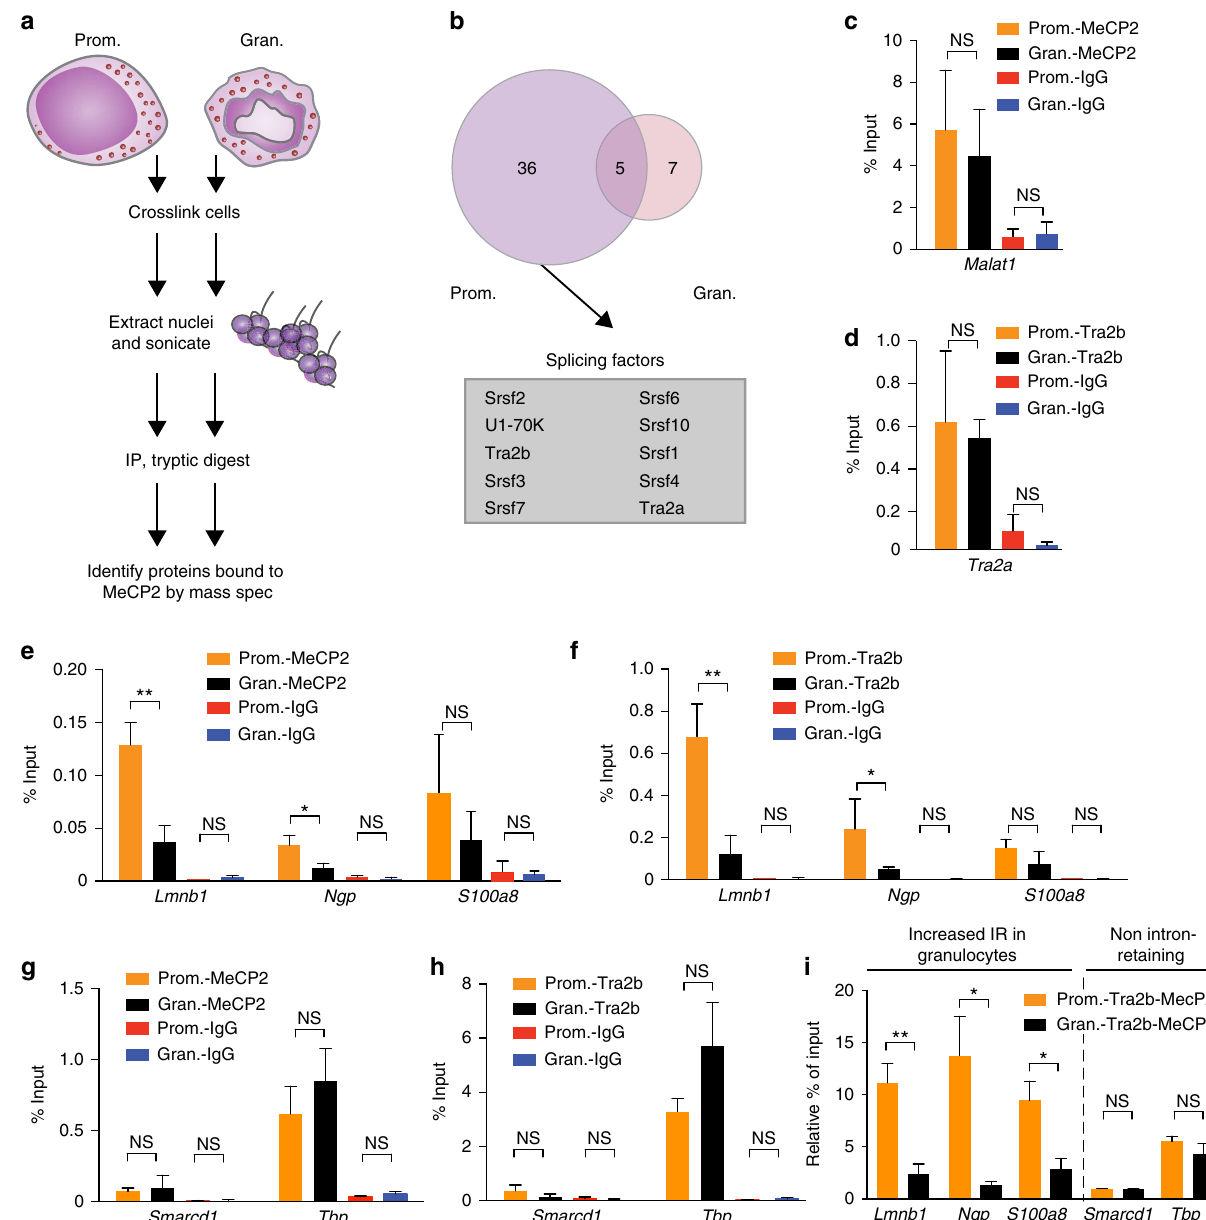
Figure 5 | Reduced MeCP2-mediated recruitment of the splicing factor Tra2b promotes IR. ( a ) Schematic of the RIME assay to identify MeCP2 binding partners in normal promyelocytes (Prom.) and granulocytes (Gran.). ( b ) Venn diagram showing proteins that bind to MeCP2 in promyelocytes and/or granulocytes. MeCP2 bound splicing factors enriched in promyelocytes are listed. ( c ) Occupancies of MeCP2 and ( d ) Tra2b in the coding region of Malat1 and Tra2a in promyelocytes and granulocytes measured by RNA-IP followed by qRT-PCR. ( e ) Occupancies of MeCP2 and ( f ) Tra2b near splice junctions of Lmnb1 intron 5, Ngp intron 3 and S100a8 intron 2 in normal promyelocytes compared to granulocytes by RNA-IP. ( g ) Occupancies of MeCP2 and ( h ) Tra2b near splice junctions of constitutively spliced Smarcd1 intron 9 and TBP intron 5 in normal promyelocytes compared to granulocytes by RNA-IP. ( i ) Occupancies of MeCP2 and Tra2b near splice junctions of Lmnb1 intron 5, Ngp intron 3 and S100a8 intron 2, Smarcd1 intron 9 and TBP intron 5 in normal promyelocytes compared to granulocytes by RNA-IP-reIP. Levels of occupancies are shown relative to background inferred by sequential Tra2b-IgG RNA-IP controls. A two-tailed t -test was used to determine significance, denoted by * P o 0.05, ** P o 0.001 and NS, not significant. Dots and bars